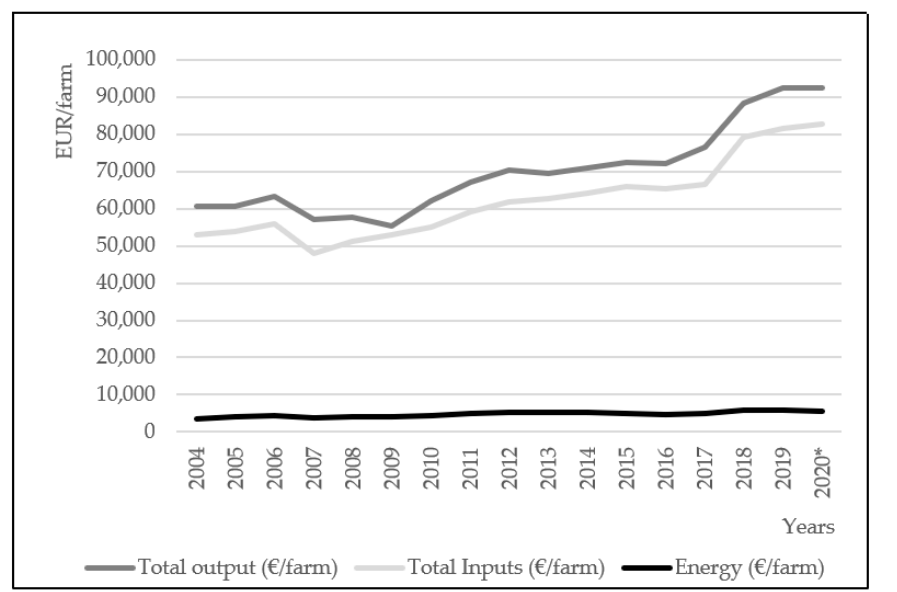
Figure 1. Total output, inputs and energy cost by farm in the European Union in 2004–2020. Source: own preparation based on Table 1. * Including the United Kingdom.